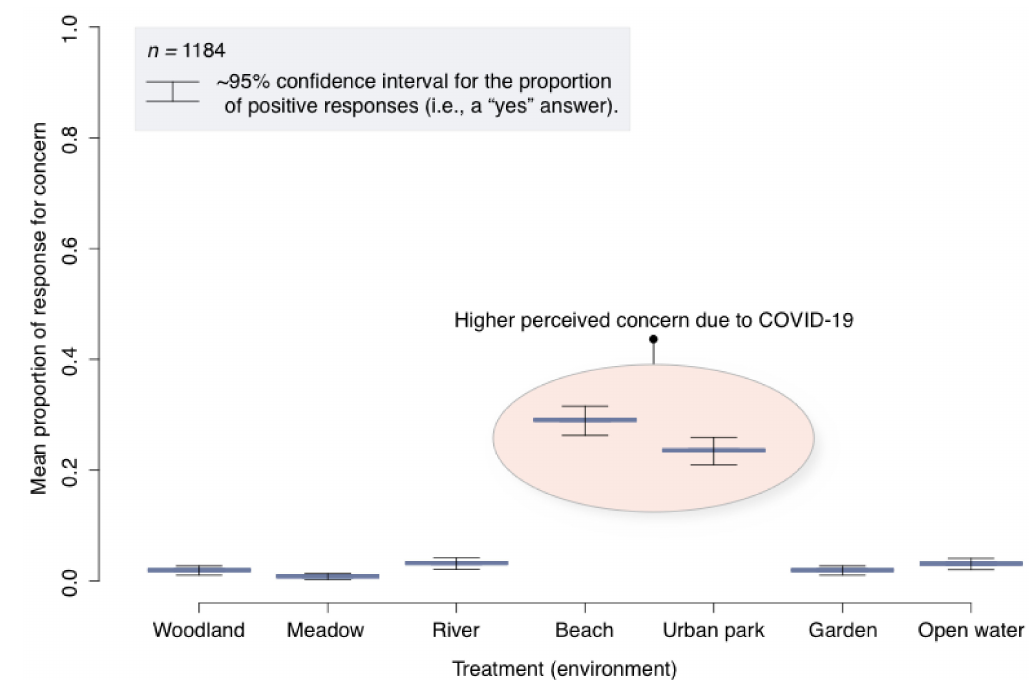
Figure 4. Boxplot for the GLM analysis (regarding environments of concern due to COVID-19), showing means and approximate 95% confidence intervals for the proportion of positive responses, where “yes” was recoded to “1”.